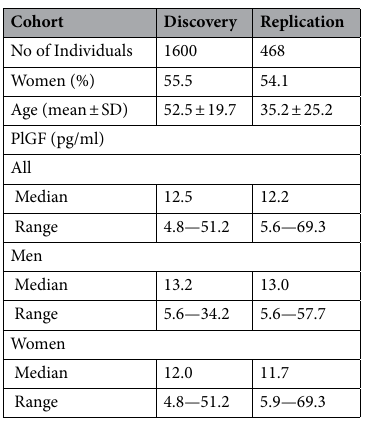
Table 1. Characteristics of study participants from the discovery and replication